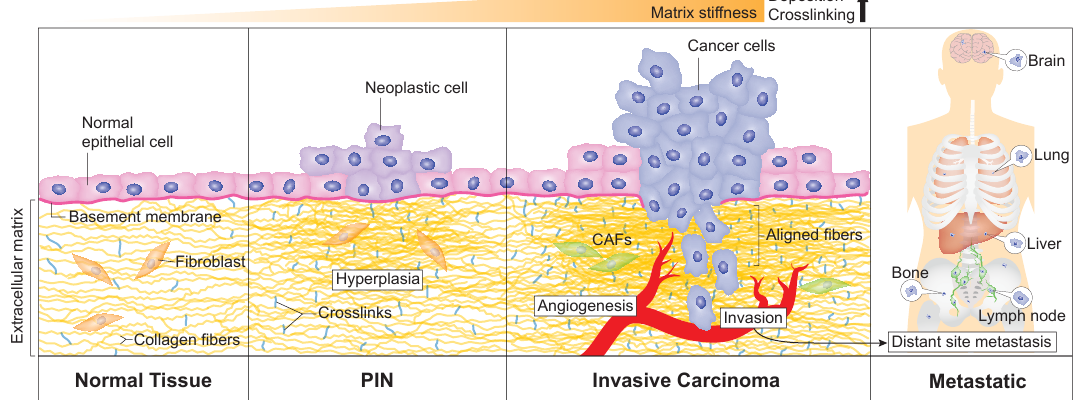
Figure 1. Gradual increase of ECM stiffness and prostate cancer progression. As prostate cells slowly progress towards prostatic intraepithelial neoplasia (PIN) and ultimately into invasive disease, the extracellular matrix that supports normal tissue homeostasis is gradually altered, which results in a stiffer prostate tissue. The matrix stiffness increases over time due to a greater rate of matrix components’ deposition (including type I collagen, pictured here), formation of crosslinking between ECM fibers, and ECM remodeling mediated mainly by fibroblasts and cancer-associated fibroblasts (CAF). These ECM alterations ultimately influence the hallmarks of cancer, especially angiogenesis, invasion, and distant site metastasis. Notably, fibers’ alignment can serve as paths that guide cancer cell